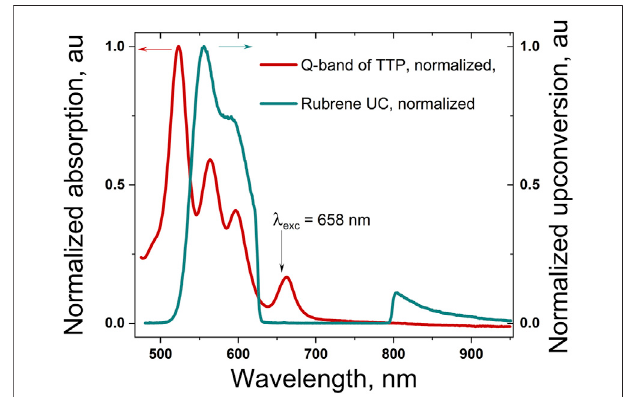
FIGURE 3 | Normalized Q-band absorption spectrum of the meso- 5,10,15,20-tetrathieno[3,2-b]thienylporphyrin,dissolvedin98toluene/2vol% squalene (the dark red line); normalized delayed fl uorescence of rubrene (the cyan curve) excited in UC regime, whose excitation wavelength λ exc = 658 nm. The excitation wavelength is suppressed by using a super broadband notch fi lter (rejection: more than 10 4 for the wavelength range centered at Δλ = 705 nm, with FWHM = 175 nm, and transparency, for all other wavelengths, better than